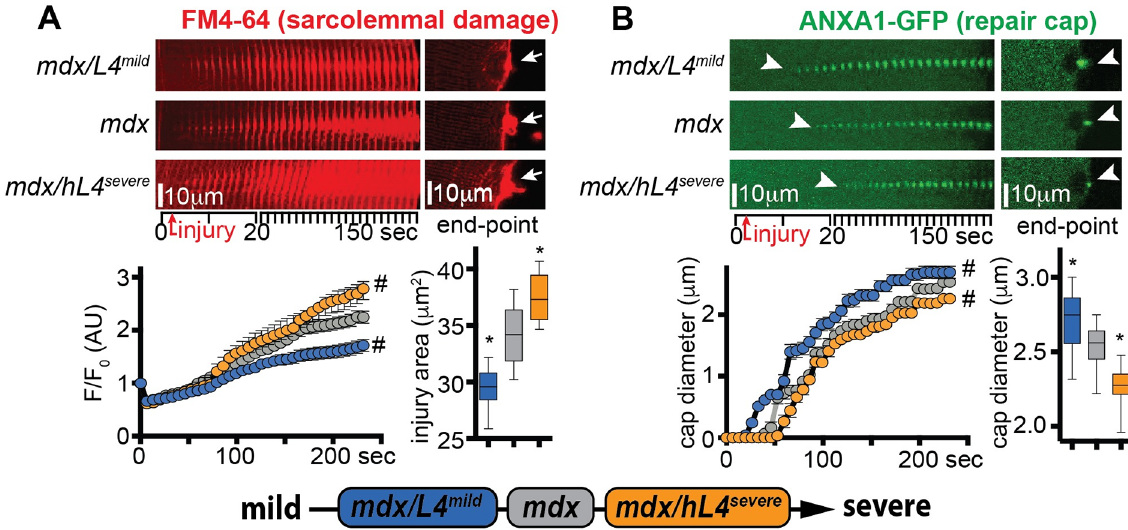
Fig 7. Disease-modifying LTBP4 isoforms differentially modify sarcolemmal repair in dystrophic muscle. Overexpression of the protective L4 mild allele in mdx mice ( mdx/L4 mild ) protects against many features of muscular dystrophy [6]. Expression of the deleterioushuman LTBP4 allele in mdx mice ( mdx/hL4 severe ) worsens muscular dystrophy [44]. A) Sarcolemmal damagewas significantly enhancedin mdx/hL4 severe myofibers, as comparedto littermate, background-matched mdx myofibers, both over time and at end-point(arrows). Conversely, sarcolemmal damagewas reducedin age-matched mdx/L4 mild myofibers. B) Repaircap formation, monitored by GFP-tagged ANXA1, was significantly delayedin mdx/hL4 severe myofibers (arrowheads), with a smaller cap diameterat end-point(arrowheads). Opposite trends were quantitated in age-matched mdx/L4 mild myofibers (arrowheads). Time series of stacked consecutive images of the injuredsite at 10˚ orientationrevealedthe extent of dye accumulationor repair cap formation. FM4-64 and ANXA1-GFP pictures were acquired simultaneously. Marked line plots, avg ± sem;box plots, Tukey distribution; n = 50 myofibers (5 mice)/group;#, P < 0.05vs mdx , 2way ANOVA + Bonferroni; * , P < 0.05vs mdx , 1way ANOVA +